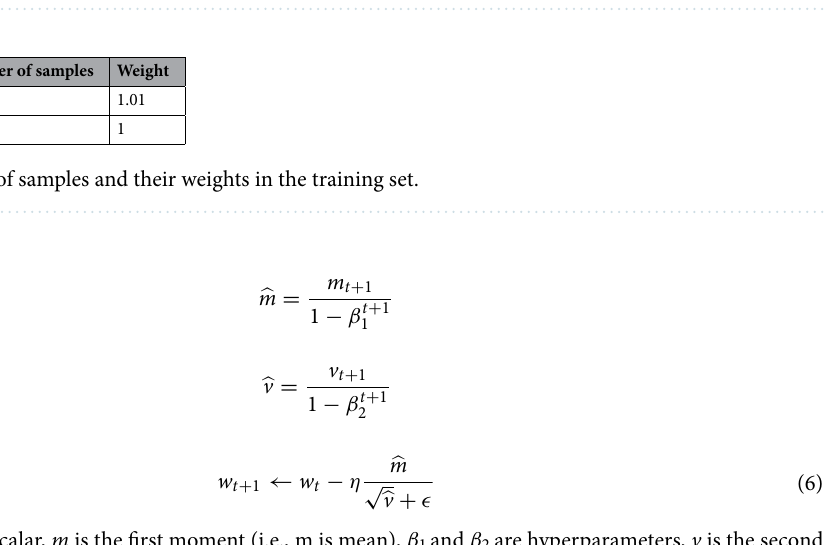
Figure 4. Samples of the dataset classes. Source: Authors’ construction using Jupyter Notebook, and Python version 3.7.